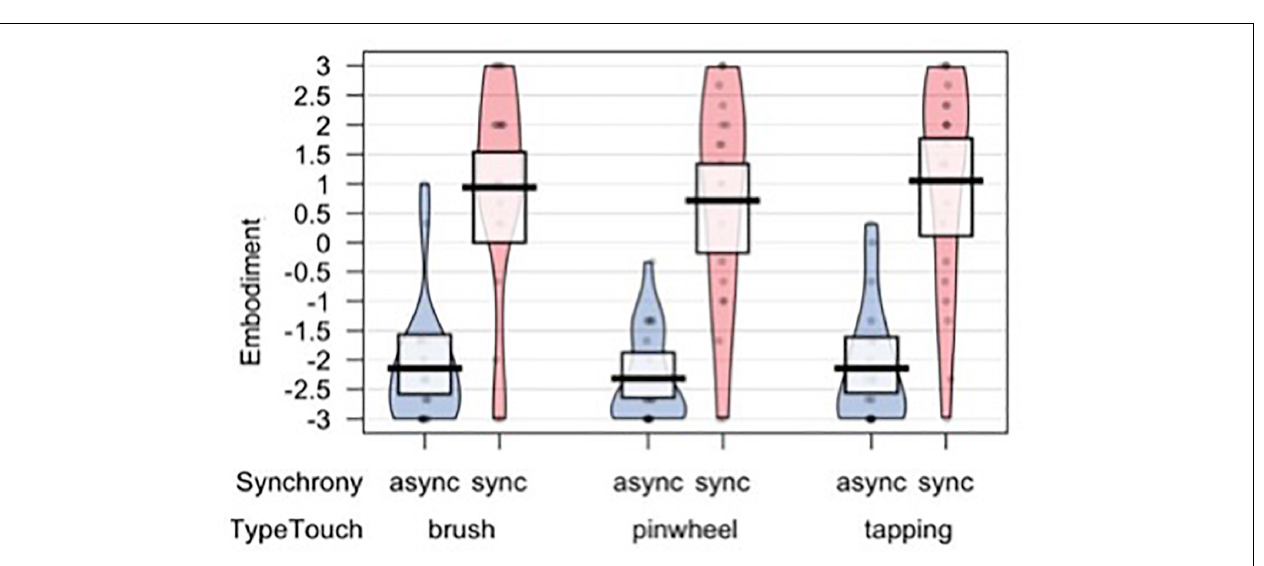
FIGURE 6 | Embodiment score measuring the subjective illusion